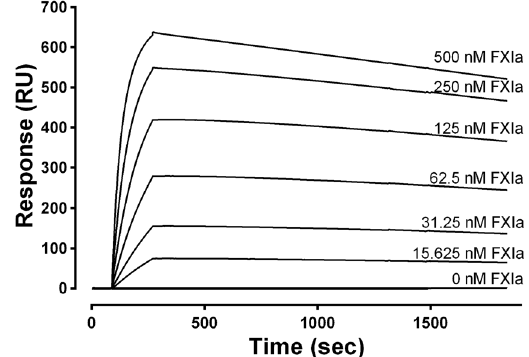
Figure 6. Binding of FELIAP to immobilized FXIa. An SPR sensogram showing the interactions between 3 ′ biotinylated FELIAP immobilized on a streptavidin-coated chip and FXIa at 25 °C at FXIa concentrations given above each progress curves. Association was allowed to proceed for 180 seconds followed by 1800 seconds of dissociation. All curves were corrected for non-specific effects by signal subtraction using a reference cell containing 3 ′ biotinylated SCRAPT immobilized on a streptavidin-coated chip. A single dilution series of curves representative of a total of 3 others is shown.